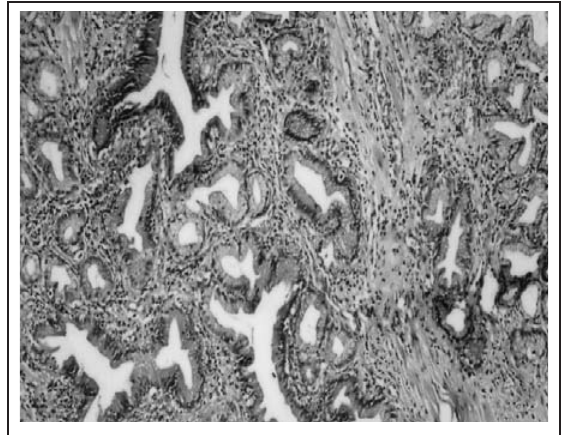
Figure 2. Intestinal metaplasia in chronic cholecysti- tis (H&E X100).